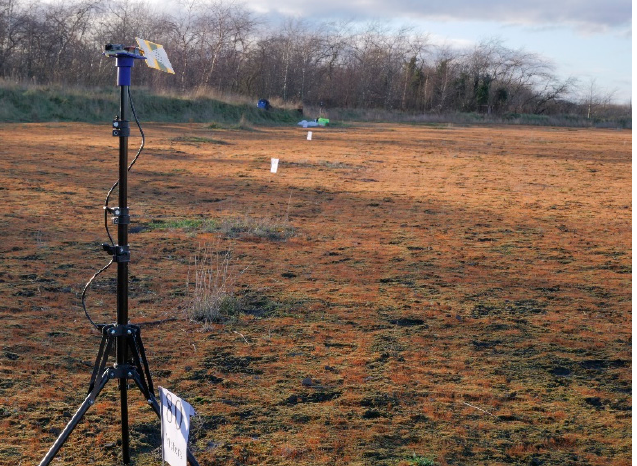
Figure 5. Setup for the received signal strength indicator (RSSI) tests for receive and transmit an- tennas.